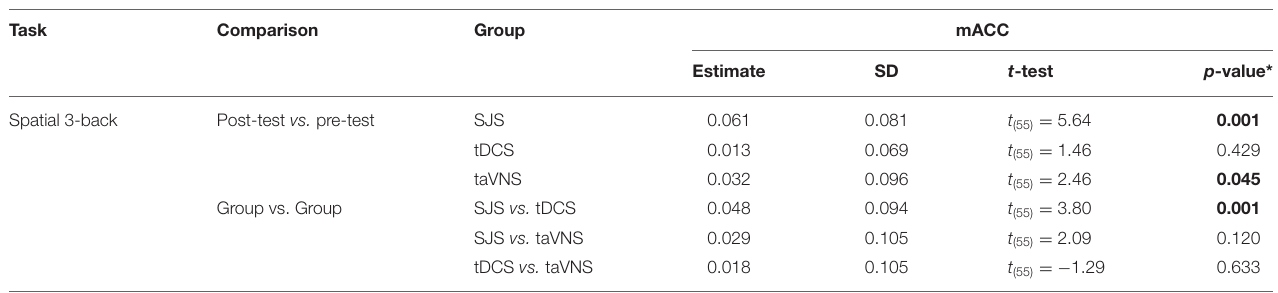
TABLE 2 | Post-hoc of significant time–stimulation interactions.